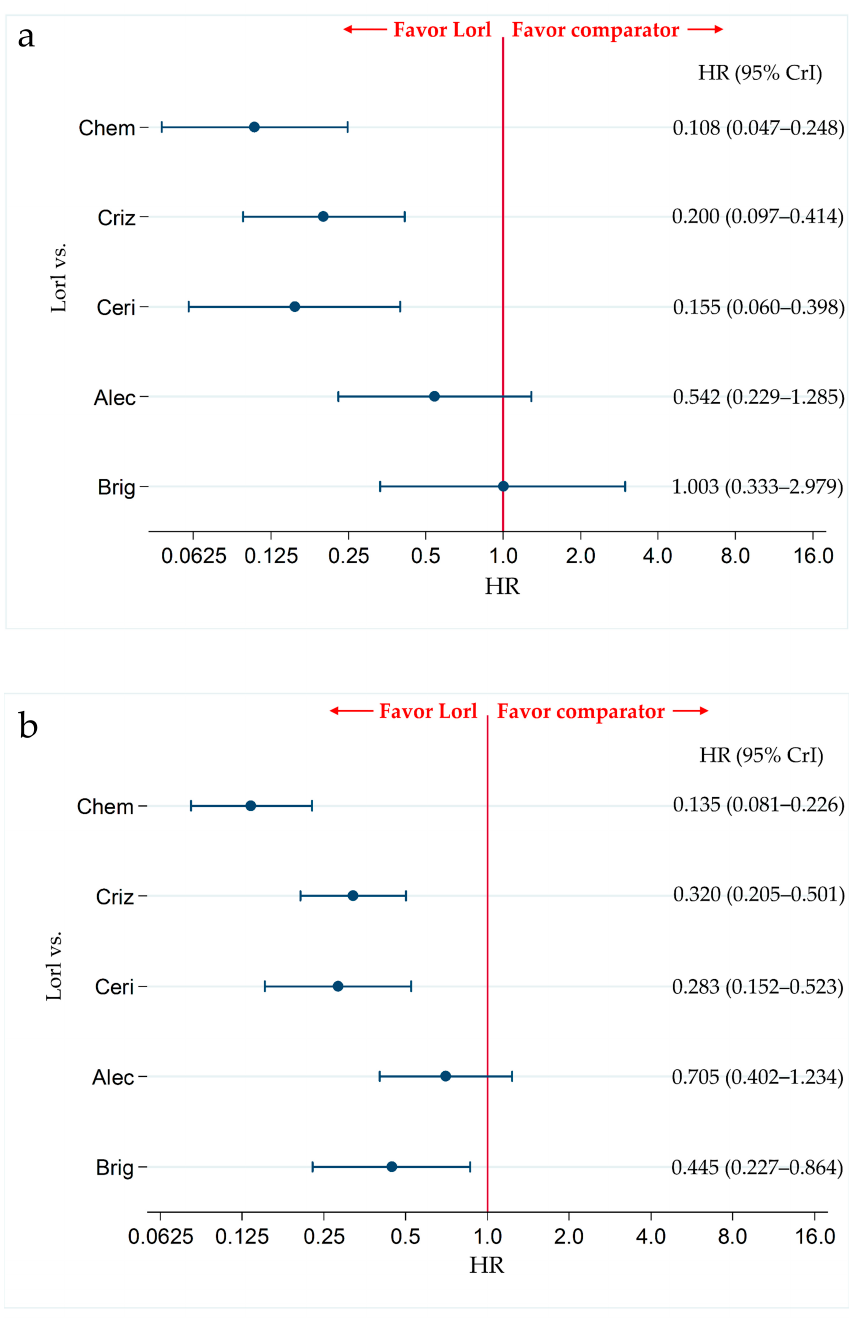
Figure 6. Comparative efficacy of lorlatinib and existing therapeutics in terms of PFS in ALK-p ALK-inhibitor-naïve advanced NSCLC patients with and without CNS metastasis. A comparison between the PFS of patients with ALK-p ALK-inhibitor-naïve advanced NSCLC who were treated with lorlatinib and each of the other five therapeutic agents, chemotherapy, crizotinib, ceritinib, alectinib, and brigatinib as comparator is presented. Comparisons are expressed as lorlatinib versus each of the comparator agents. Data are expressed as hazard ratios (HRs) and 95% credible intervals (CrIs); ( a ) Comparison in the subgroup of patients with CNS metastases; ( b ) Comparison in the subgroup of patients without CNS metastases. PFS, progression-free survival; ALK, Anaplastic Lymphoma Kinase; ALK-p, Anaplastic Lymphoma Kinase-positive; NSCLC, non-small cell lung cancer; Lorl, lorlatinib; Brig, brigatinib; Alec, alectinib; Ceri, ceritinib; Criz, crizotinib; Chem, chemotherapy.